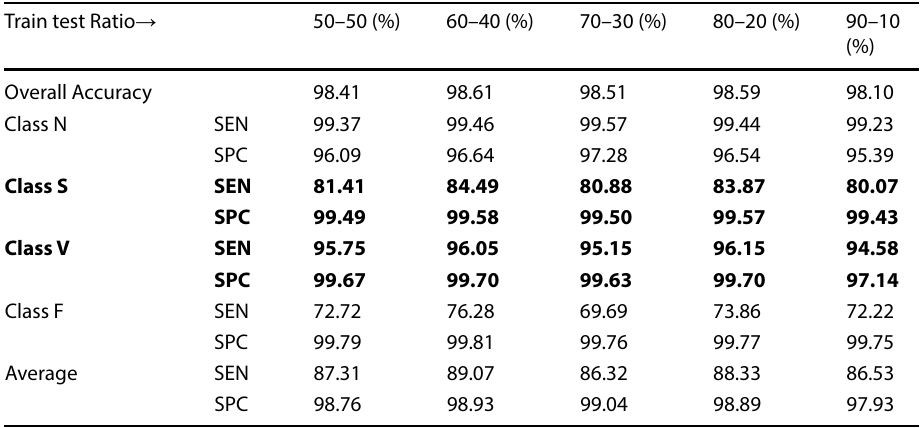
Table 4 Performance of other classifiers and our classifier